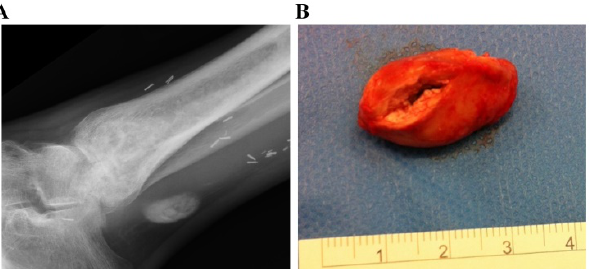
Figure 3. Radiograph (a) at 10 months showing a small radiodense area of extruded antibiotic carrier adjacent to the tibialis posterior tendon. The bone defect has remodelled well with no sign of recurrent infection. At operation, a 1x2x2.5cm soft mass of calcium sulphate was removed